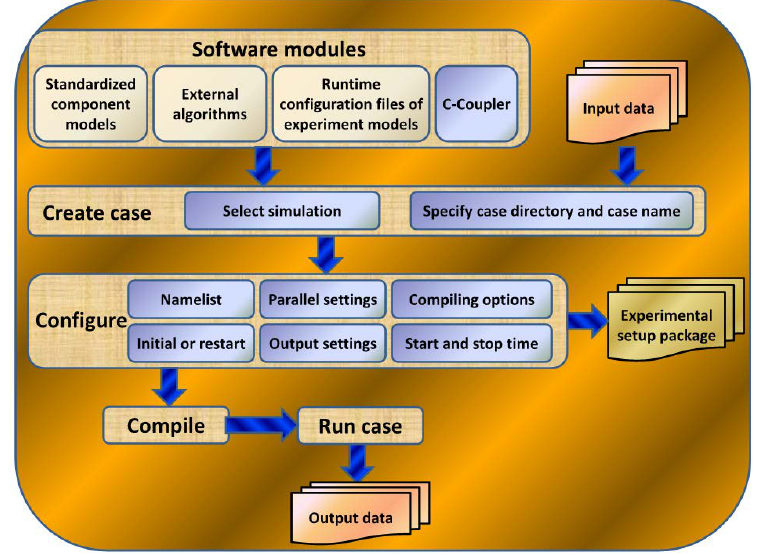
Fig. 3. The general software architecture of the C-Coupler platform. 2 Figure 5. The general software architecture of the C-Coupler